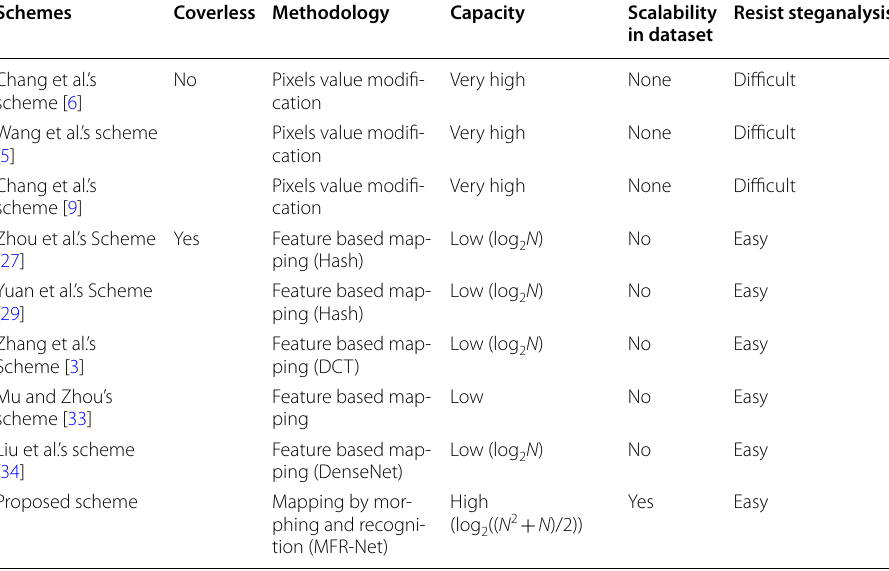
Table 8 Comparisons of features among different schemes Schemes Coverless Methodology